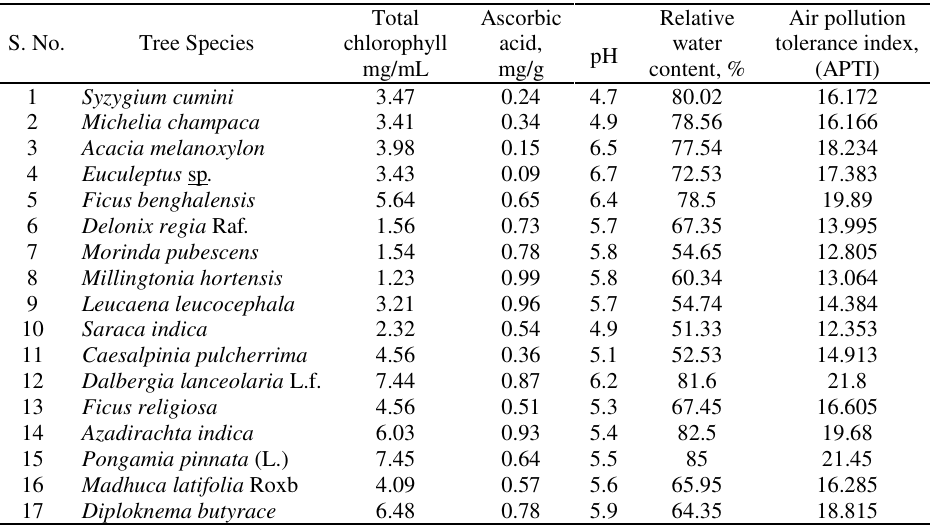
Table 3. Air pollution tolerance index (APTI) for tree species from Electronic city of south Bengaluru